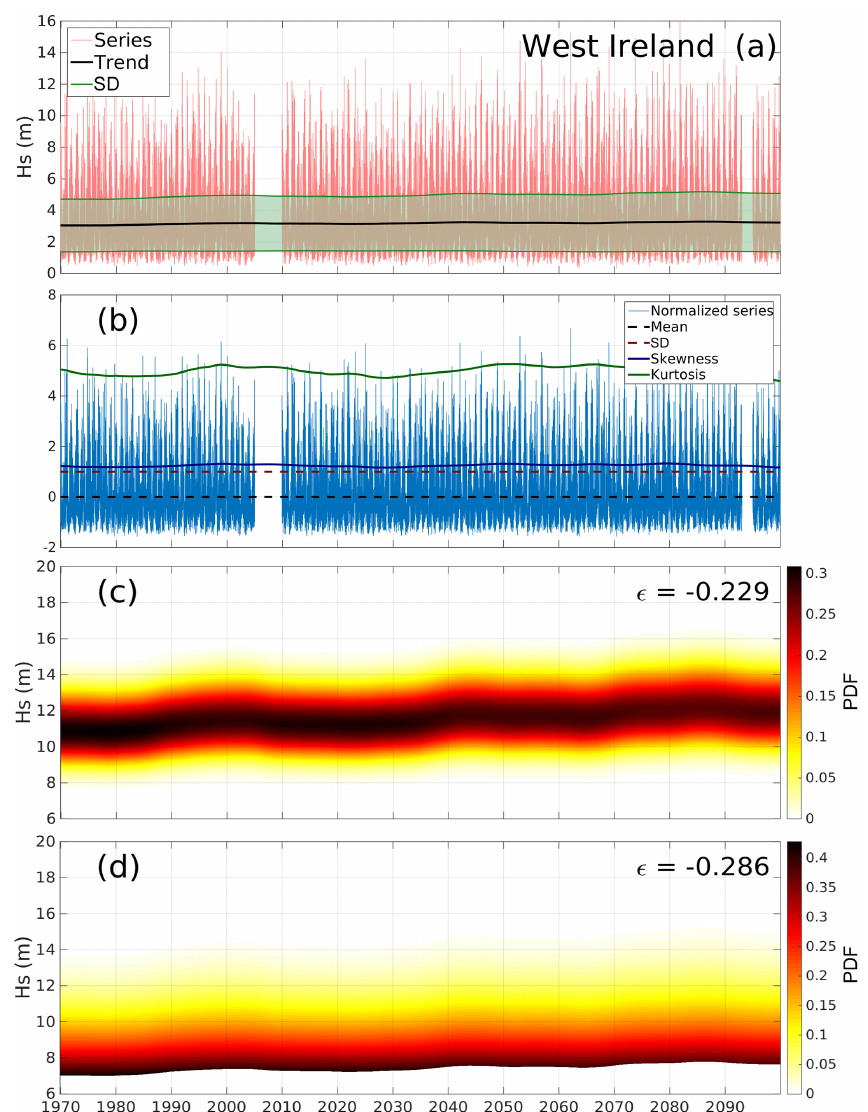
Figure 2. Long-term analysis of the projections of significant wave height in Cape Horn: (a) series, its trend, and standard deviation; (b) the normalized series with higher order statistical indicators; (c) non-stationary GEV of annual maxima; (d) non-stationary GPD of annual peaks. In (c) and (d) the values of the shape parameter ε best fitted for the GEV and GPD distributions are reported.